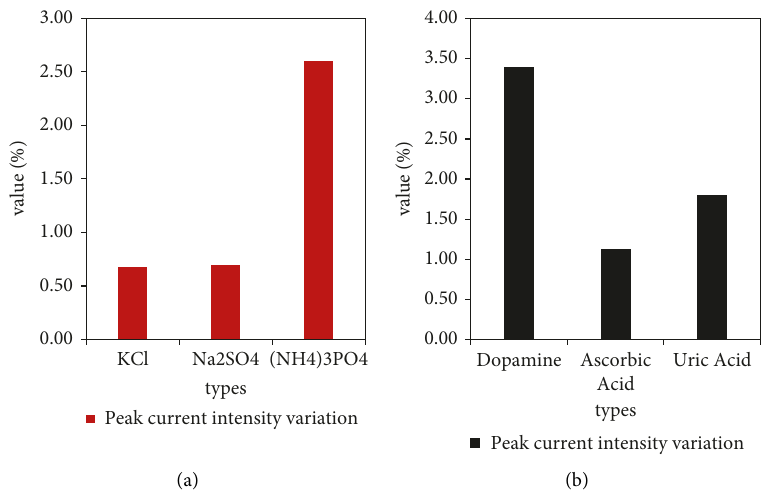
Figure 7: Response results of PtNPs/RGO/GCE in rutin solution to interfering ions.